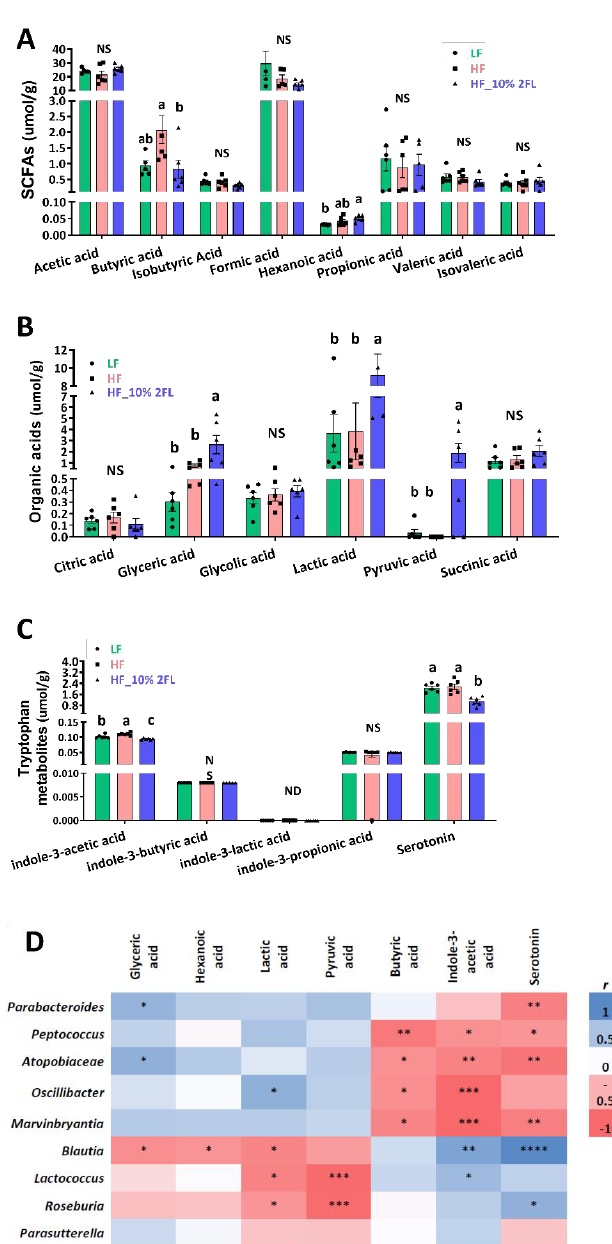
Figure 4. E ff ect of 10% 2 (cid:48) -FL supplementation on metabolomic profiles in the cecum of mice fed an LF, HF, or HF_10% 2 (cid:48) -FL diet for six weeks. One-factor ANOVA was performed to analyze metabolomic data. Di ff erences between groups were analyzed by using Tukey’s post hoc tests. Correlation between cecal microbiome and metabolites was determined by using the nonparametric Spearman correlation analysis. Values are means ± SEMs, n = 6 / group. Di ff erent letters denote significant di ff erences between groups at p < 0.05. Metabolite concentrations ( A – C ) and heatmap visualization of microbiota–metabolome correlation analysis ( D ); blue and red colors indicate a positive or negative Spearman correlation, respectively. Histogram with di ff erent letters (a or b) denotes mean values that are statistically di ff erent at p < 0.05; for all variables with the same letter, the di ff erence between the means is not statistically significant and if two variables have di ff erent letters, they are significantly di ff erent. ND, not detected; NS, not significant. * p < 0.05, ** p < 0.01, *** p < 0.001, **** p < 0.0001. ANOVA, analysis of variance; HF, high fat; HF_10 % 2 (cid:48) - FL, HF with 10% 2 (cid:48) -FL ( w / v ) in drinking water; LF, low fat; SCFA, short chain fatty acid; 2 (cid:48)